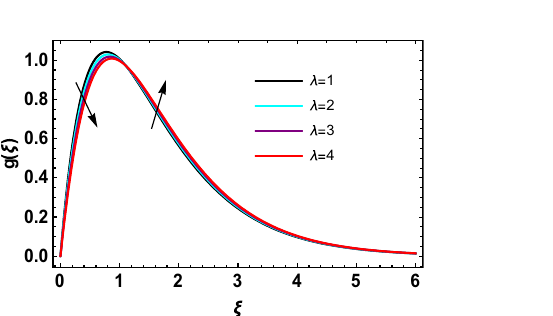
Figure 8. Impact of (cid:31) upon g (ξ) .